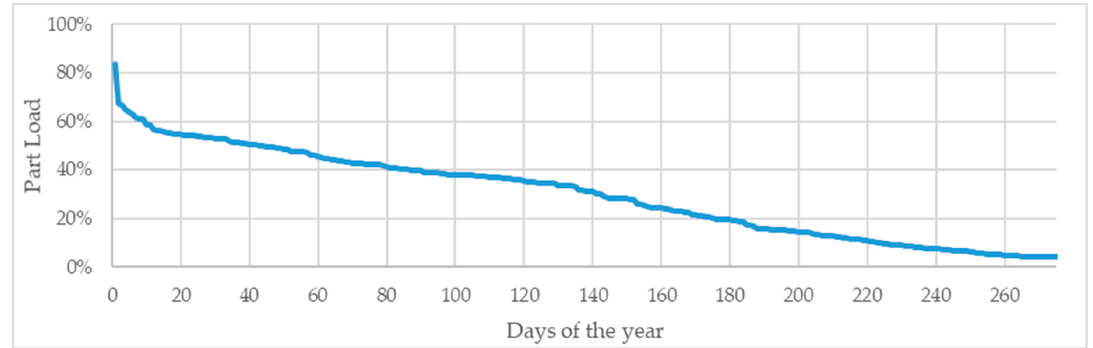
Figure 4. Part load operation of the radiator system of the building case study in relation to the number of days during 2017, expressed as a duration curve.